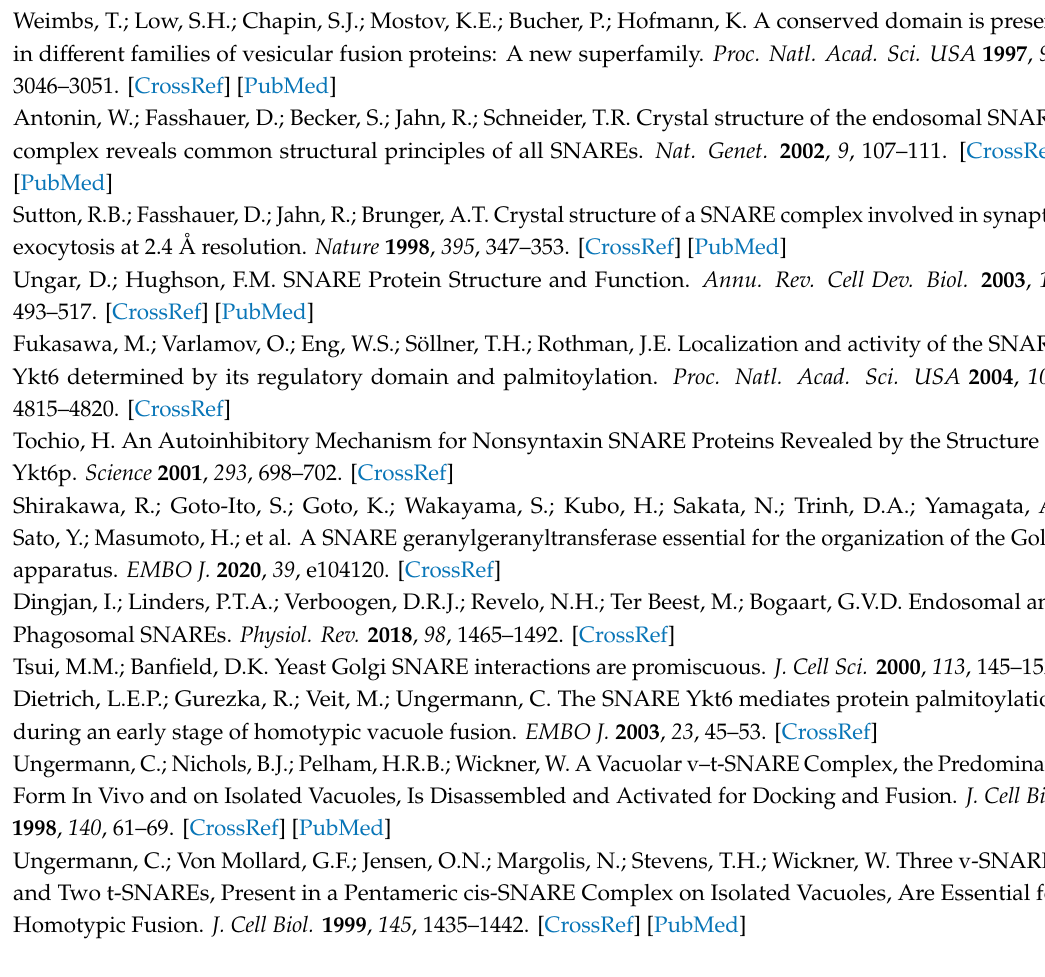
Table S1: Ykt6 SNARE in vitro kinase screening results. Kinase finder and validation screen. Supplementary Table S2: Proteins identified by mass spectrometry from BioID control, Ykt6-WT and Ykt6-3E samples in two technical replicates by SWATH (for experimental details see Material and Methods section). Supplementary Table S3: List of